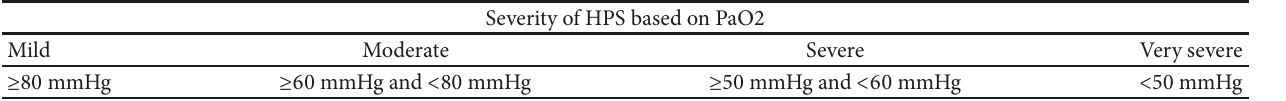
Table 3: Severity of